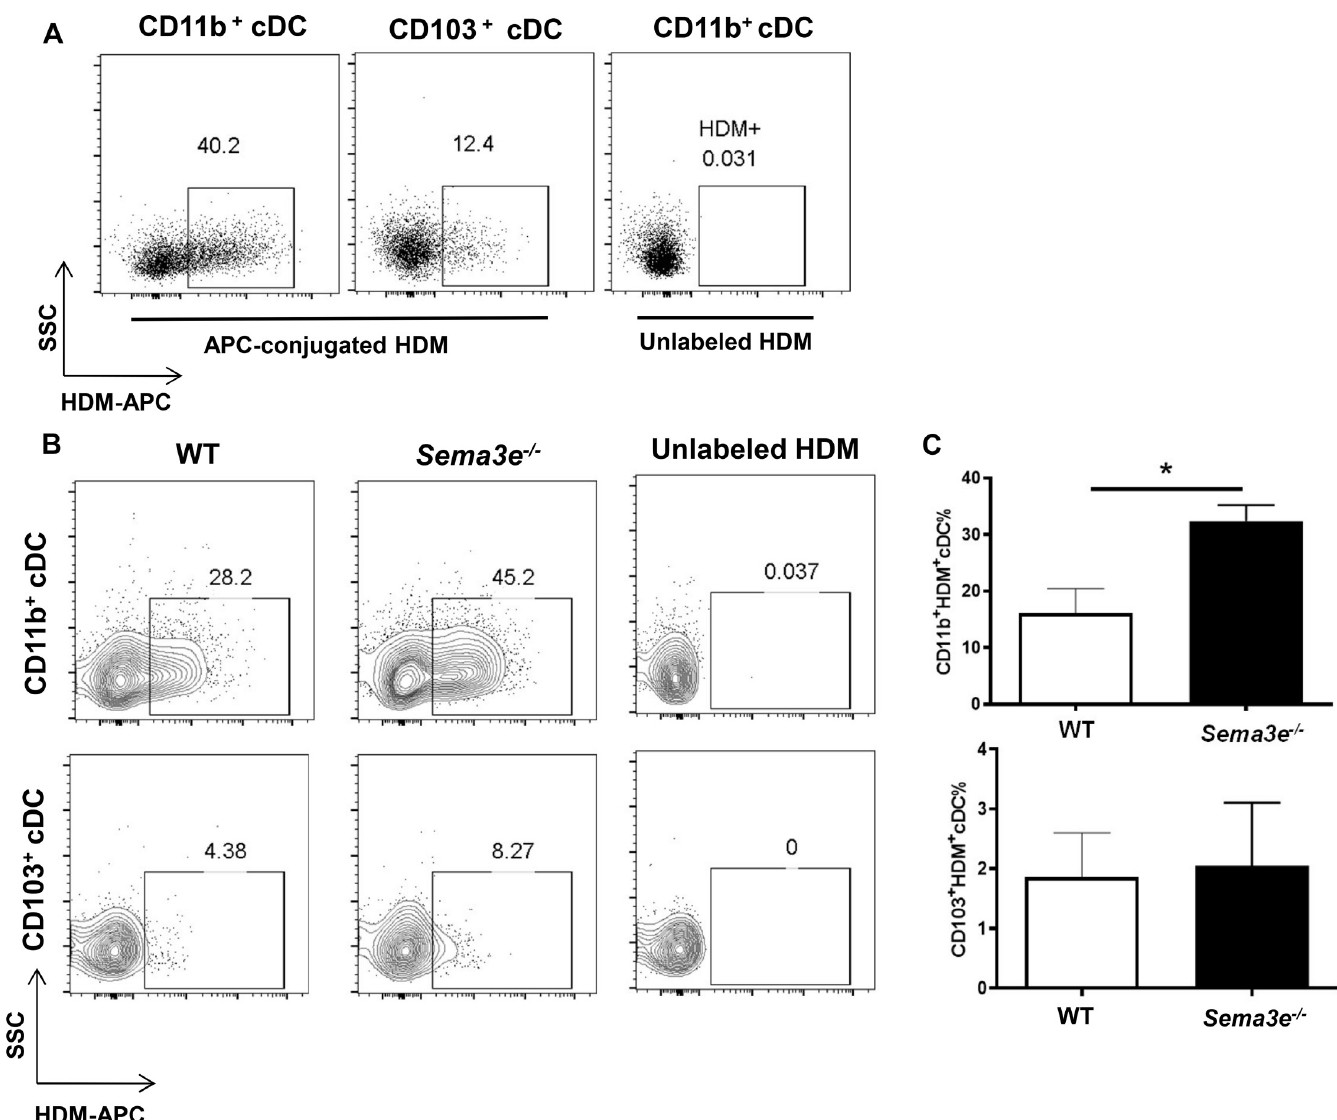
Fig 4. Enhanced uptake of HDM in pulmonary cDC subsets from Sema3e -/- mice. HDM allergen was fluorescently labelled using a conjugation kit and intranasally administered to the mice followed by acquiring the samples and phenotyping CD11b + vs CD103 + cDC subsets (A). The level of HDM uptake by pulmonary cDC subsets was compared between Sema3e -/- and WT mice. cDC from the mice sensitized with unlabeled HDM was served as a gating control (n = 3 per group) (B–C).